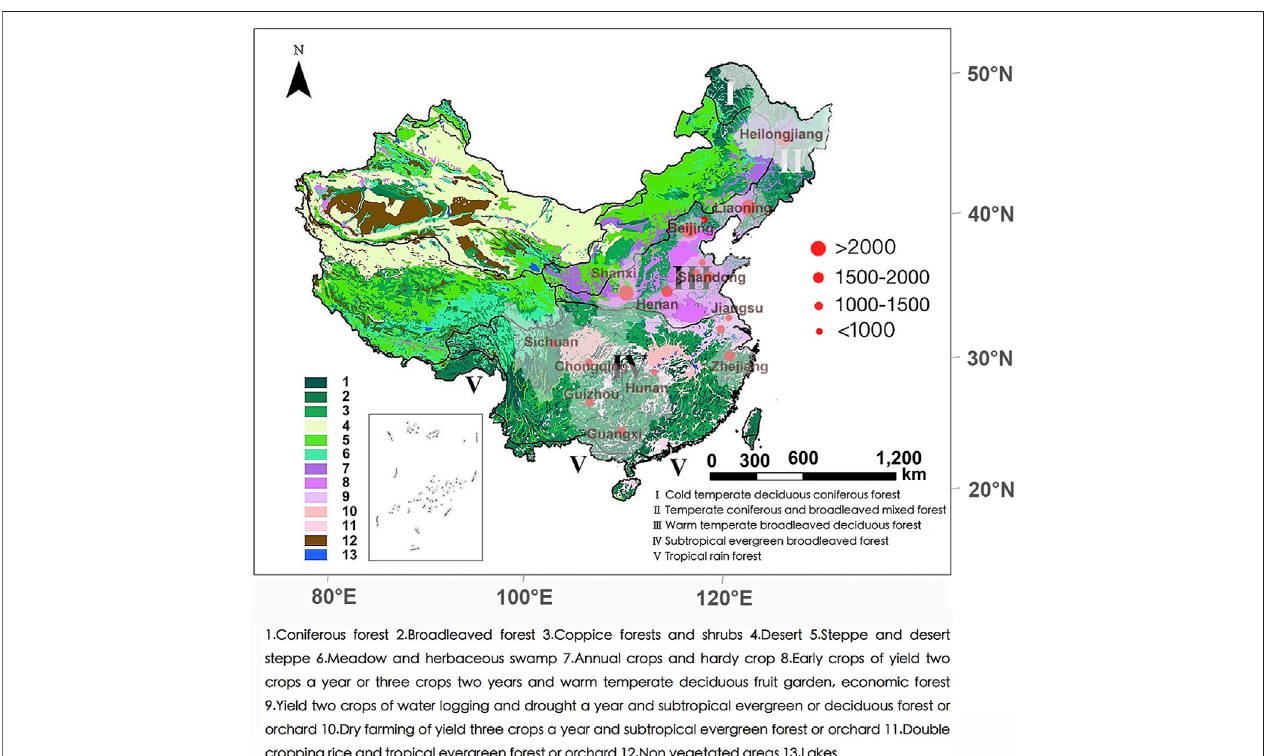
FIGURE 1 | The distribution of sites and vegetation types in the study area. The red dots represent the selected sites, and their size represents the data volume of phenological data of sites. The different colors of the base map represent the different types of plants from the vegetation map of China (1:4,000,000) (Hou, 1983). The vegetation regionalization map of China (1:6,000,000) was provided by the Data Center for Resources and Environmental Sciences, Chinese Academy of Sciences (http://www.resdc.cn).